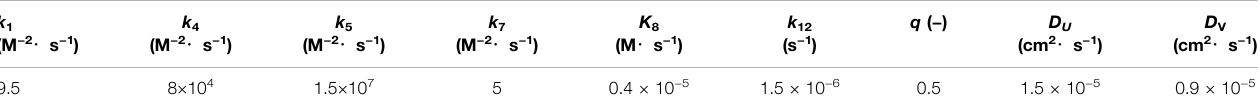
TABLE 3 | Tuned values of reaction and diffusion constants.